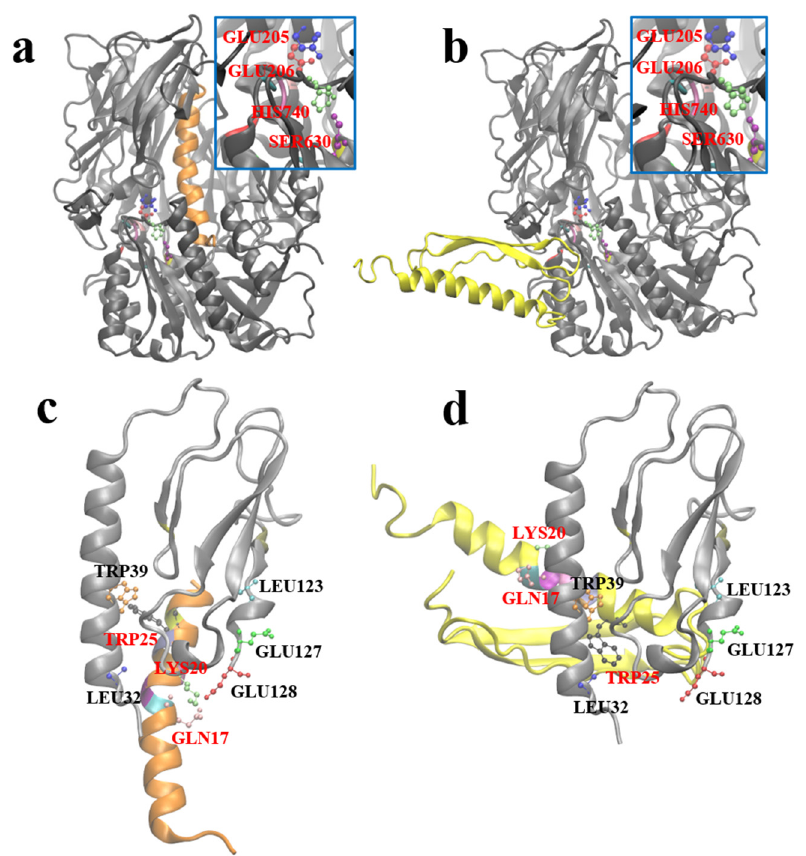
Figure 7. Molecular docking structures. ( a ) GLP-1 and DPP-4 molecule complex. ( b ) G1 and DPP-4 molecule complex. ( c ) GLP-1 and GLP-1R complex. ( d ) G1 and GLP-1R complex. The DPP-4, GLP-1, and G1 GLP-1R are colored by gray, orange, yellow and sliver, respectively. In DPP-4, the represented active residues GLU205, GLU206, SER630 and HIS740 are colored by blue, red, lime and purple, respectively. In GLP-1, the represented active residues GLN17, LYS20 and TRP25 are colored by pink, lime and black, respectively. In GLP-1R, the represented active residues LEU32, TRP39, LEU123, GLU127 and GLU128 are colored by blue, orange, cyan, green and red, respectively. The represented active residues are highlighted by CPK model, and other active residues are showed by New Cartoon model.